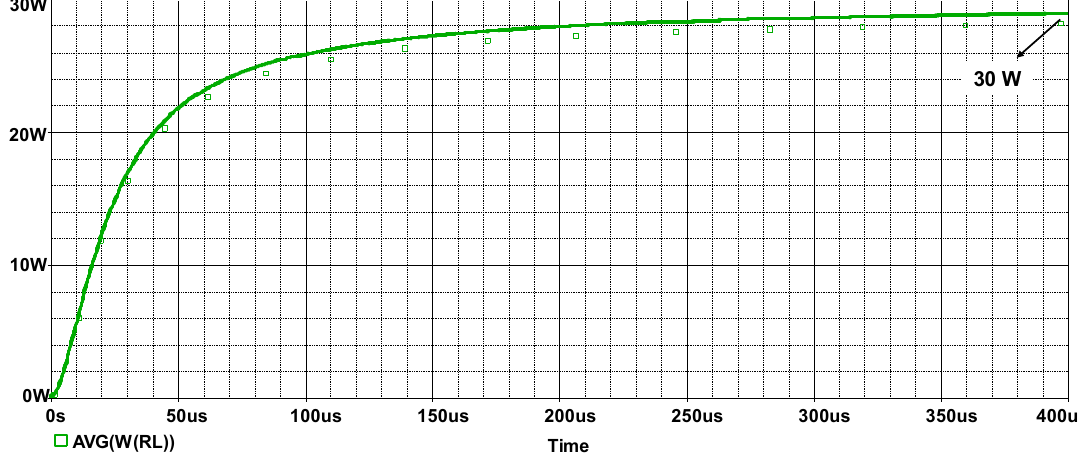
Figure 10. Average output power ( P o ) at the load resistor.